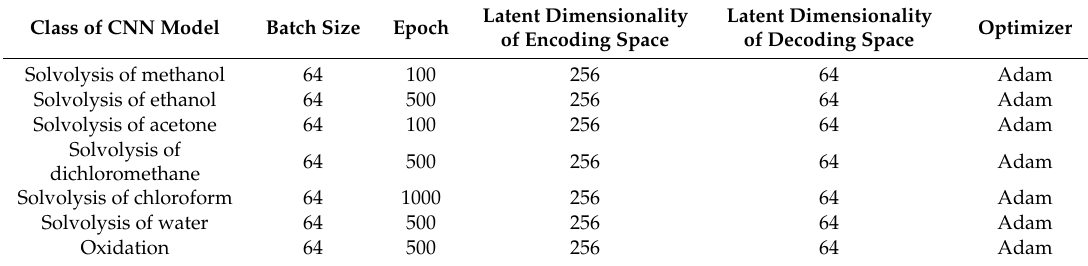
Figure 2. ( A ) Architecture of the neural networks for predicting the reactions of natural products to artifacts. ( B ) Illustration of the convolutional neural network (CNN)-based neural networks in training mode. Table 2. Key hyperparameters of the best-performing CNN models.